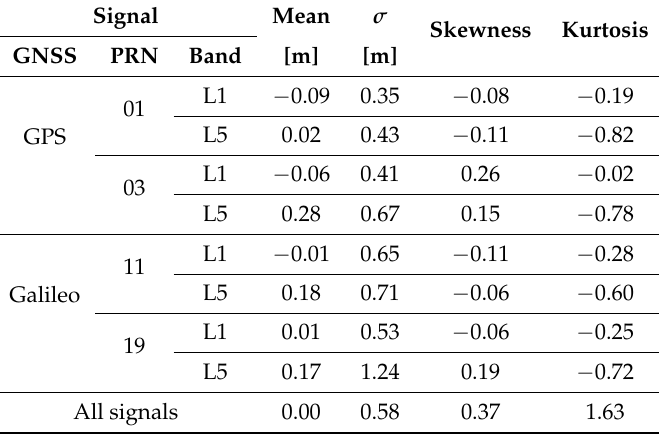
Table 2. Statistical moments of ∆ ρ with respect to the linear fit for each global navigation satellite system (GNSS) signal and their combination. Integration time applied: 10 ms (coherent) and 10 s